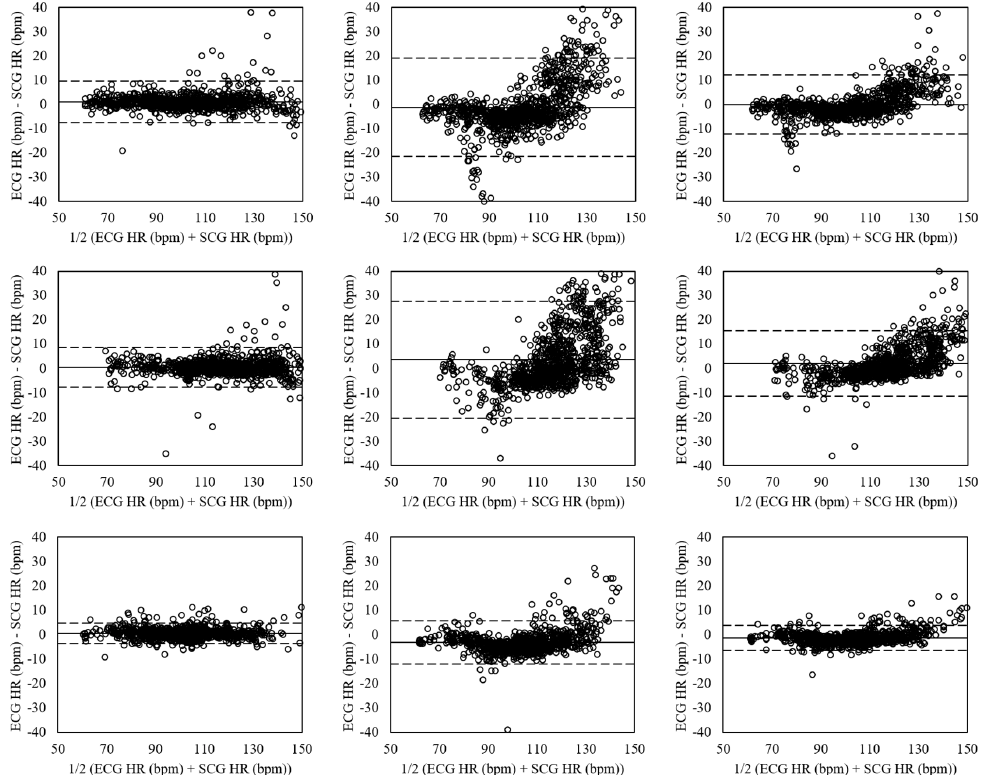
Figure 8. Bland-Altman plots of heart rates estimated from SCG and ECG by CNNs in aroused condition for sitting ( Left ), standing ( Mid ), and supine ( Right ) postures based on the VGG-16 without data augmentation ( Top ), VGG-19 with data augmentation ( Mid ), and ensemble network ( Down ). The lines are the mean errors and 95% LOA.